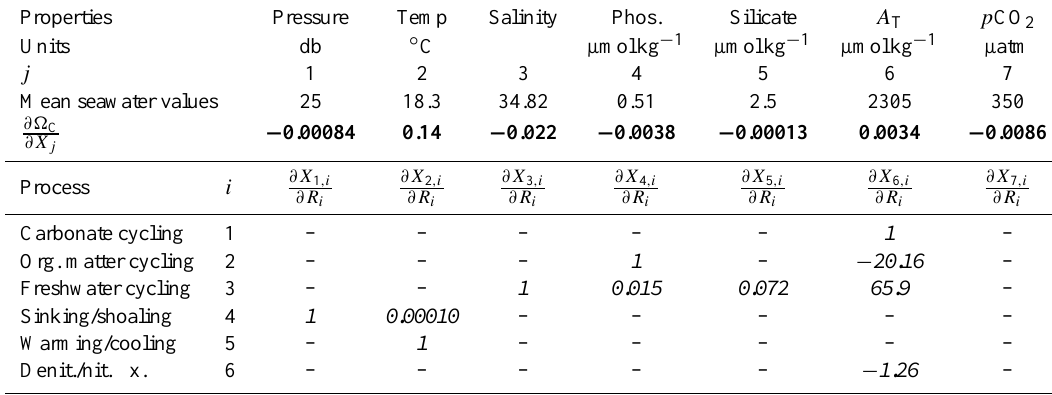
are the inverse of the listed ∂X j